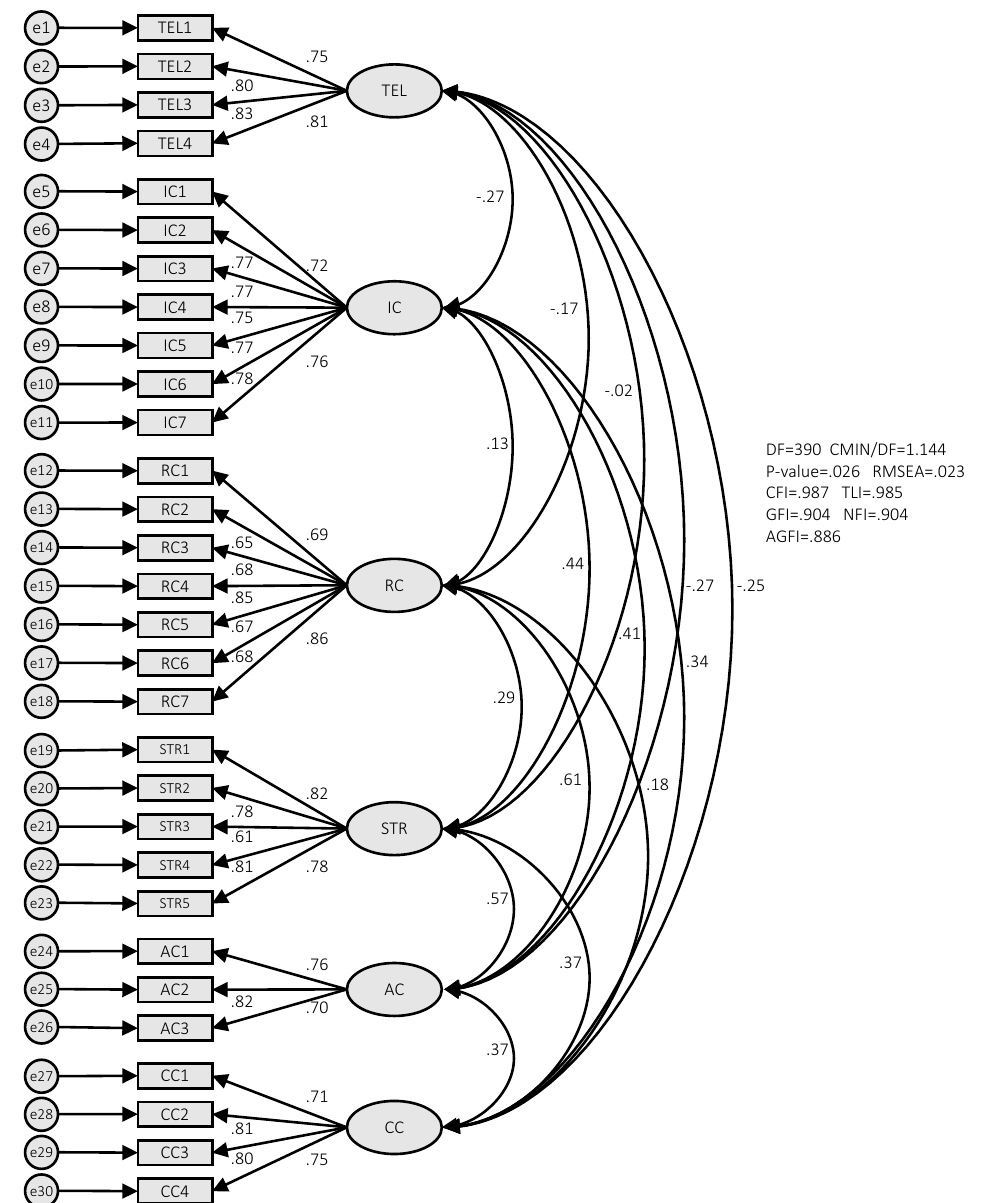
Figure 2. Confirmatory factor analysis